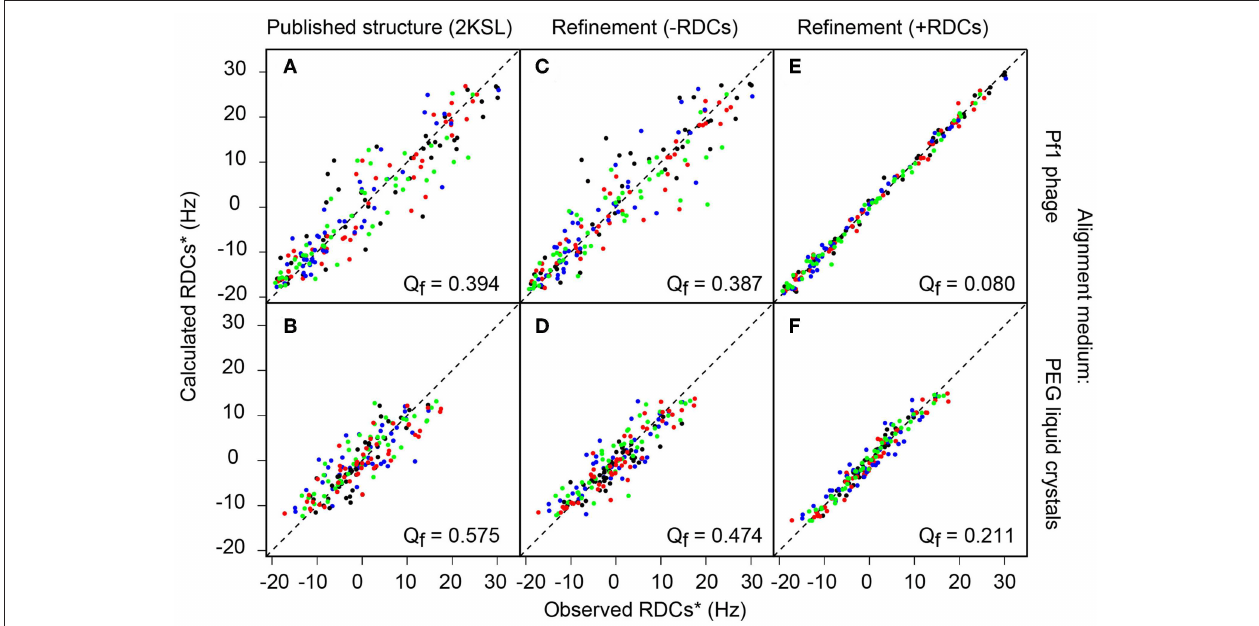
FIGURE 2 | Plots of experimental vs. back-calculated RDCs using different Ta1a structures. The three columns refer to different structures, the left column (A,B) show data for the published structure, the middle column (C,D) show data for the structure refined here without RDCs and the right column (E,F) show data for the structure refined here using RDCs. The two rows show data using different alignment media (Pf1 phage top and PEG liquid crystals bottom). All RDCs ( 1 D C α H α in